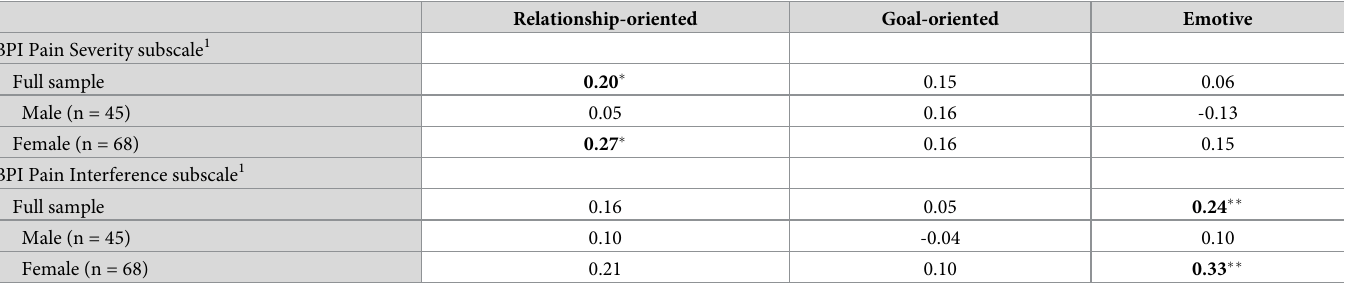
Assumptions of regression (normality, linearity, and outliers) were satisfied. No standardized residuals were beyond +/- 3.0 SD from the mean and VIF values were all < 3.3. Tables 4 and 5 provide the regression results. After partialling out the effects of sex-at-birth, only the GPES Emotive subscale significantly (P = 0.01) predicted BPI Pain Interference, explaining a unique 5.9% of score variance. There were no significant sex × GPES interactions found in any model tested. Table 3. Simple bivariate associations between GPES subscales and pain variables in the acute stage of